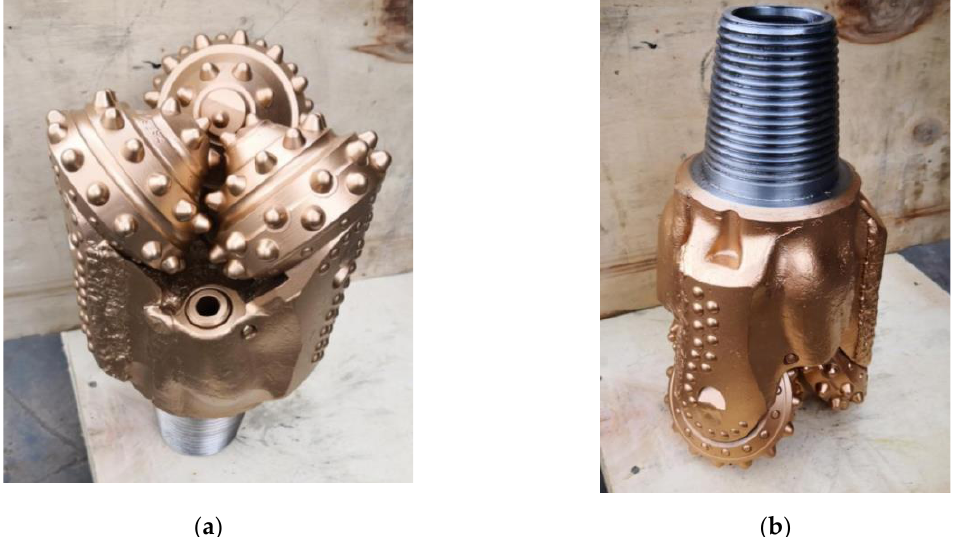
Figure 1. Example of the roller-cone drill bit: ( a ) View of the rolling cones; ( b ) View of the fixation part.